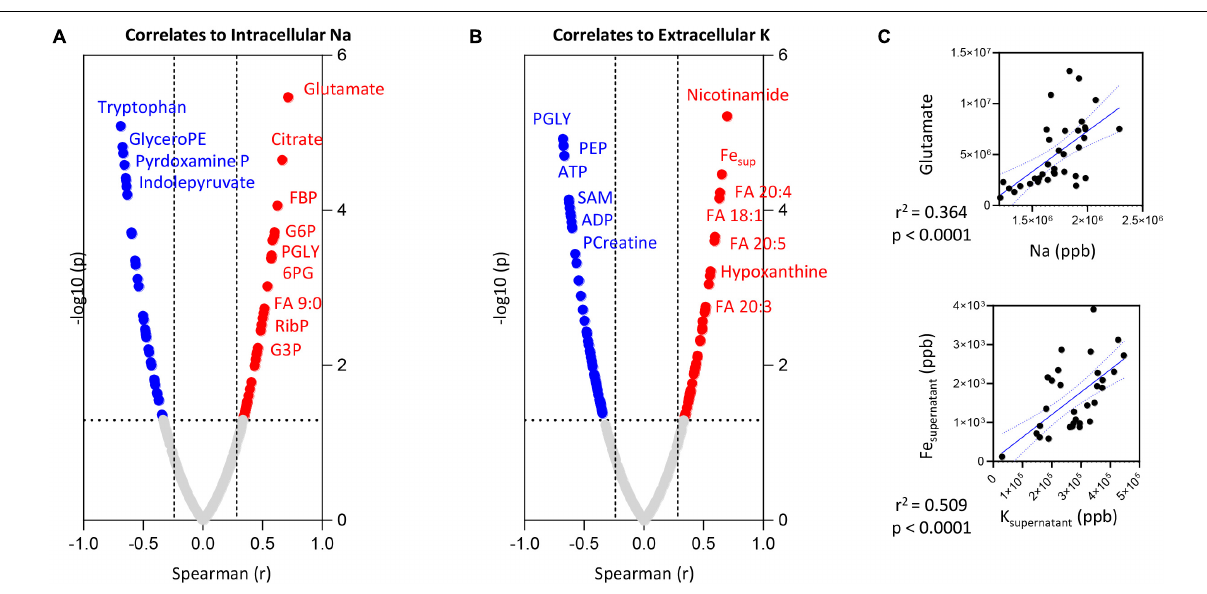
FIGURE 5 | Correlation of intracellular Na (A) or extracellular K (B) levels to RBC or superantant metabolites. In panel (C) , highlighted correlations curves for glutamate and Na (intracellular) and Fe and K